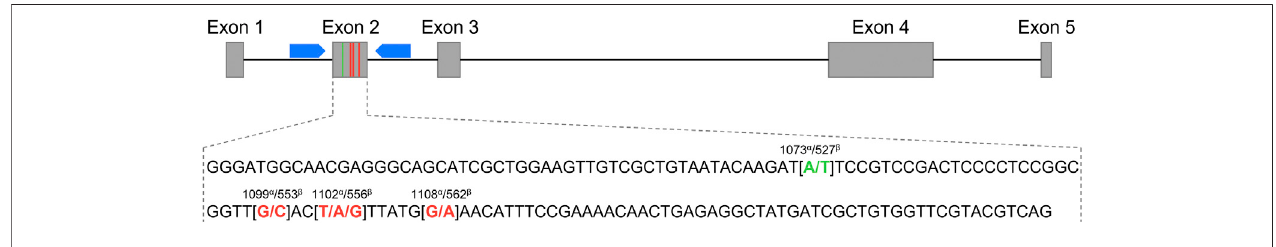
FIGURE1| Schematicrepresentationofthe Equuscaballus C-X-Cmotifchemokineligand16gene( CXCL16 )organization.Thegreyboxesrepresentexons1to5, and the black connecting lines represent introns. The blue pentagons correspond to the primers used for exon 2 sequencing. The exon 2 sequence is depicted below. TheSNPatposition1073 α /527 β usedforthegenotypingqPCRassayisshowningreen,andthethreeotherSNPsatpositions1099 α /553 β ,1102 α /556 β and1108 α /562 β are marked in red. α : annotation based on the NCBI CXCL16 gene ID: 100061442; β : annotation based on Ensembl CXCL16 gene: